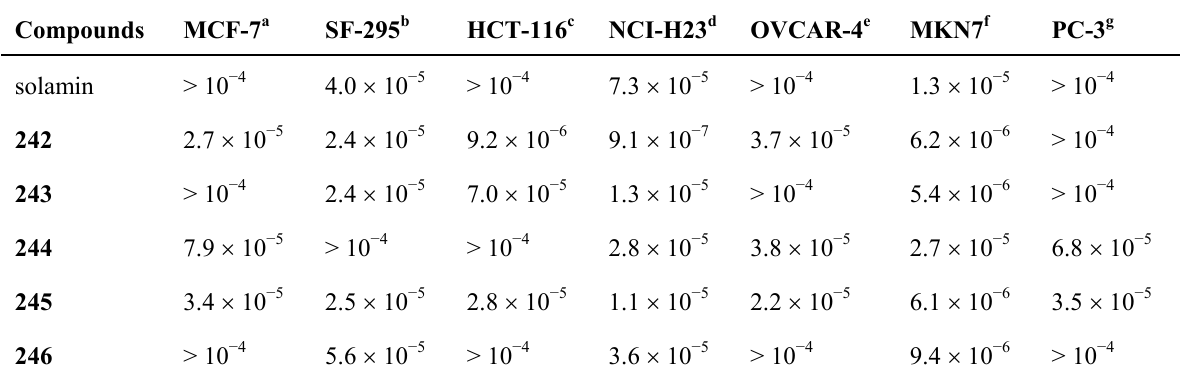
a breast cancer; b central nervous system cancer; c colon cancer; d lung cancer; e ovarian